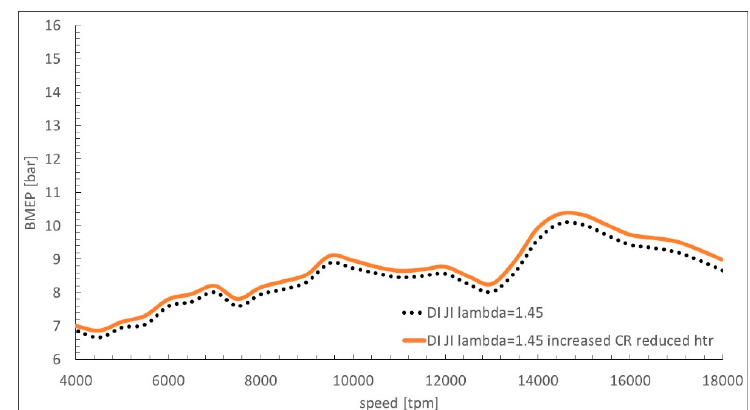
Figure 7. BMEP of lean stratified